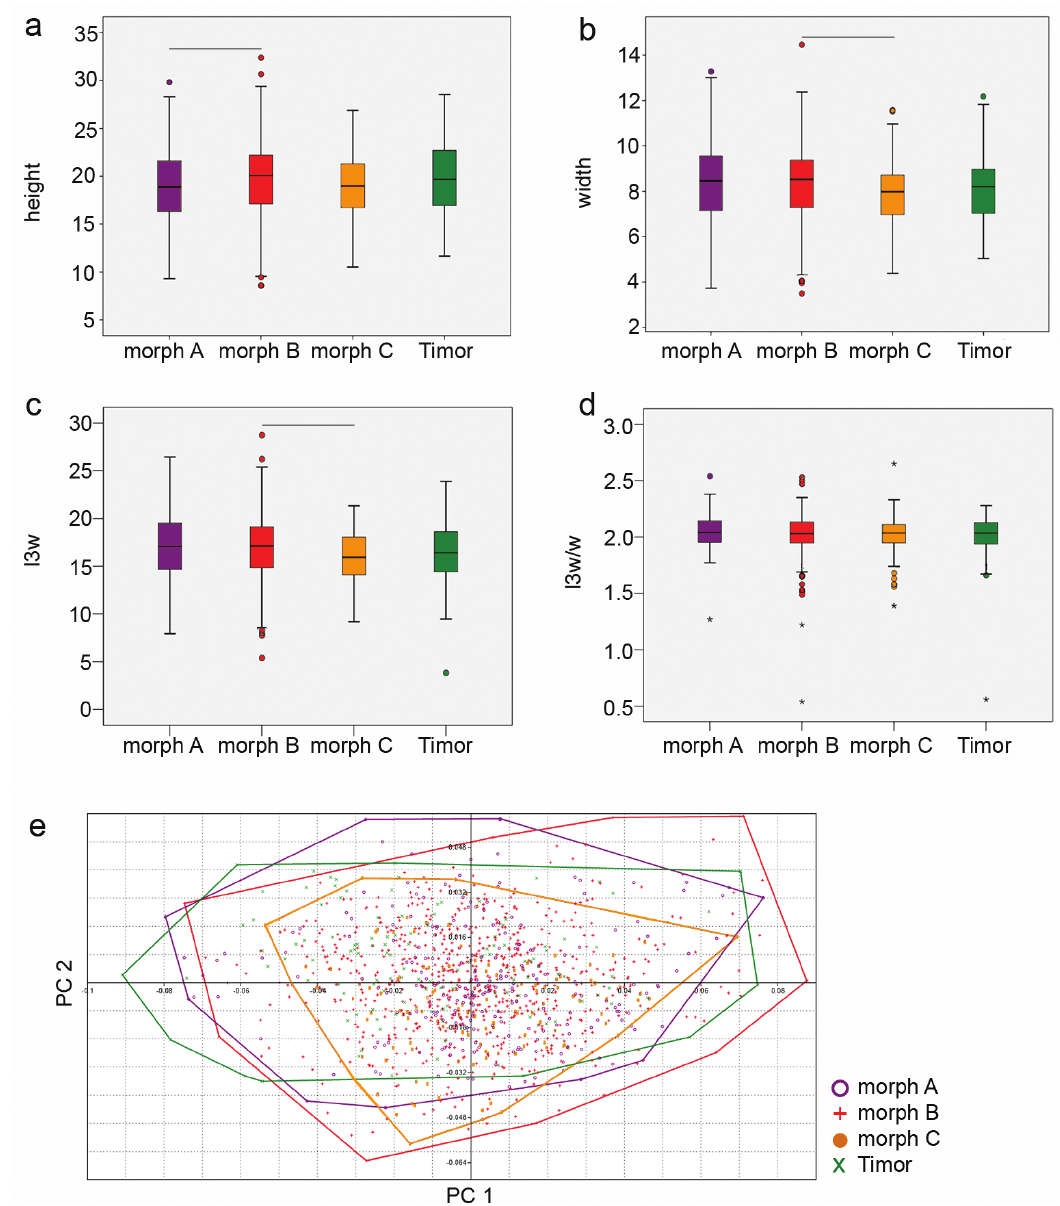
Figure 6. Results of biometric ( a–d ) and geometric morphometrics study ( e ), for four different morphs (A,B,C,Timor) of Tarebia granifera (Lamarck, 1816). Boxplots of ( a ) shell height, ( b ) shell width, ( c ) height of the last three whorls and ( d ) index of height of last three whorls agaianst shell width. Significant differences between groups are indicated by bars above the boxplots ( e ) Relative variance in shell shape along PC1 and PC2. Colour corresponding planes indicate the spread of each morph in the data